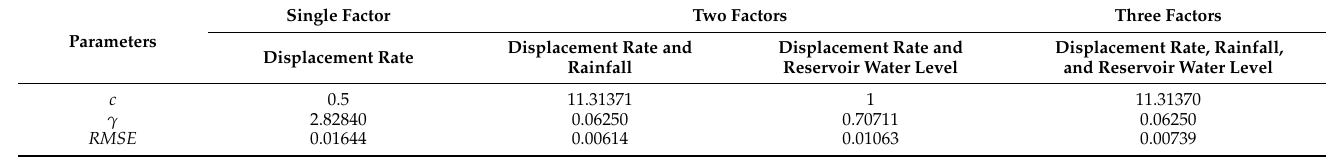
Table 2. Parameters and prediction accuracy of the models. Two